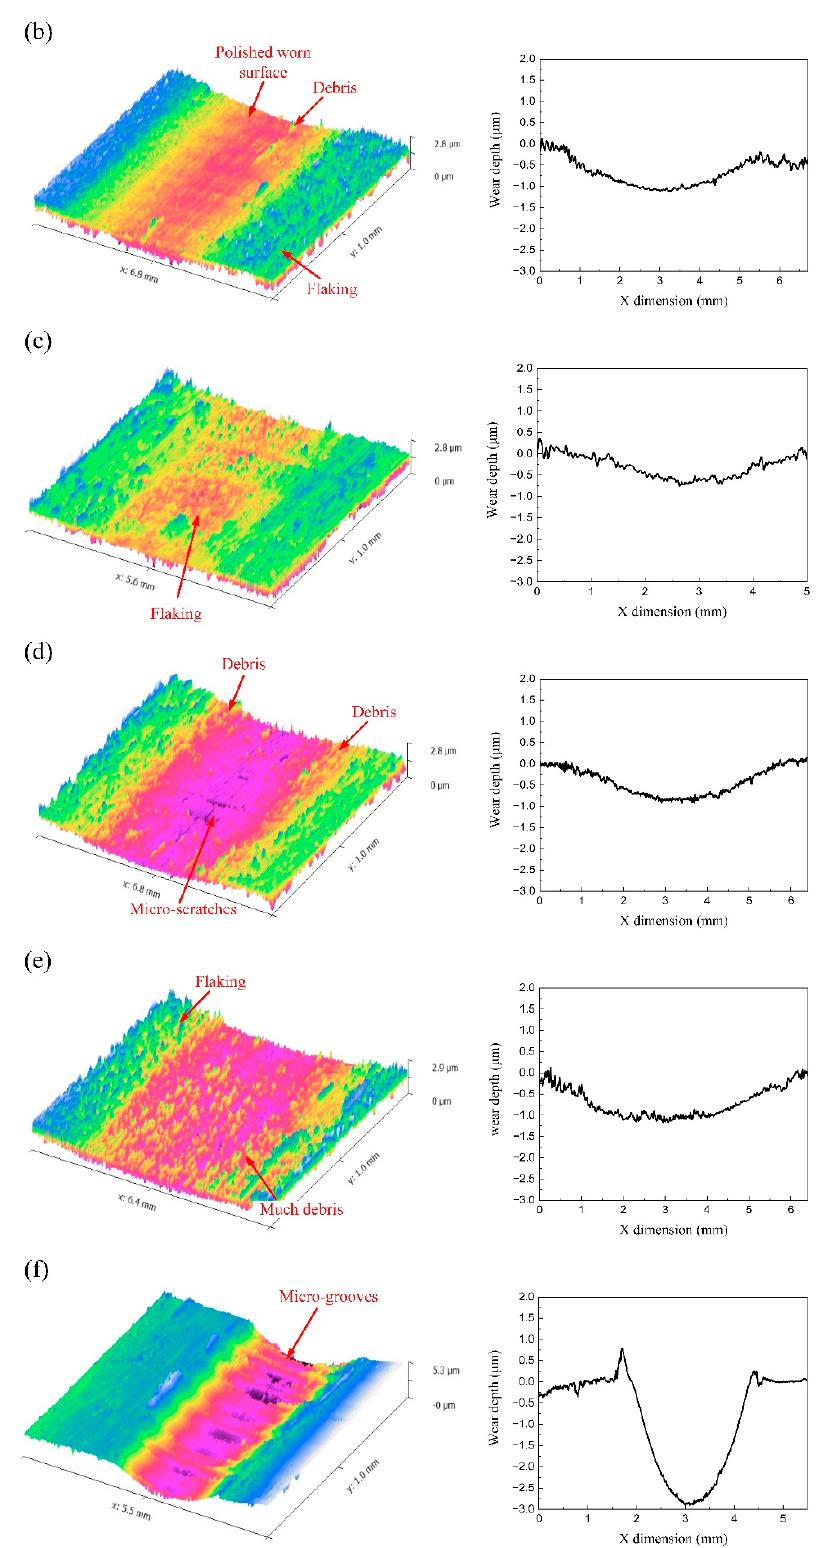
Figure 15. Worn surface morphology and profile of wear tracks: ( a ) Ti-C (100) mixed; ( b ) TiC-C (100) mixed; ( c ) TiN-C (100) mixed; ( d ) Ti-C (100) boundary; ( e ) TiC-C (100) boundary; ( f ) TiN-C (100) boundary.